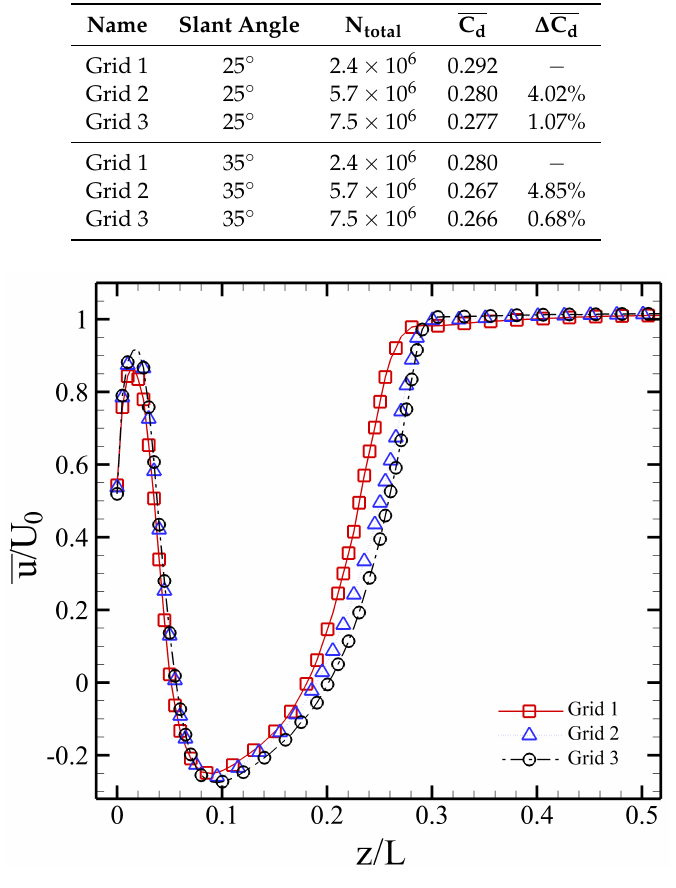
Figure 2. Comparing the mean velocity profiles at x / L = 0.25 and y / L = 0 for the the grid quality study at Re = 7.68 × 10 5 .